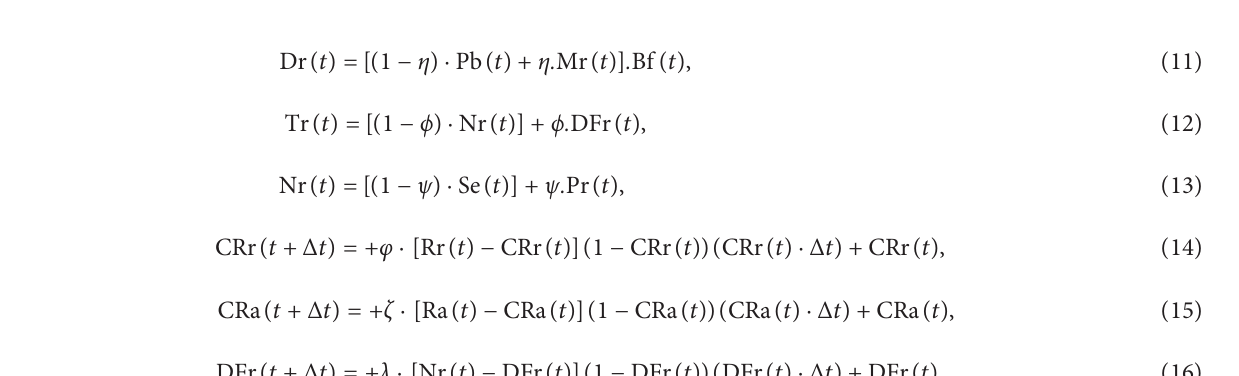
Figure 4: Te conceptual